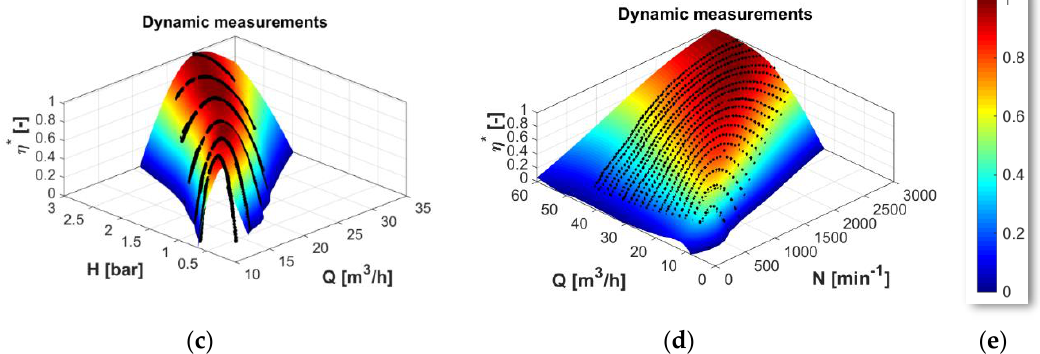
Figure 12. Resulting efficiency 3D hill-charts obtained by classical static point-by-point and by the dynamic measurement methods: ( a ) counter-rotating microturbine—result of static measurements; ( b ) PAT—result of static measurements; ( c ) counter-rotating microturbine—result of dynamic measurements; ( d ) PAT—result of dynamic measurements; ( e ) colour plot scale.